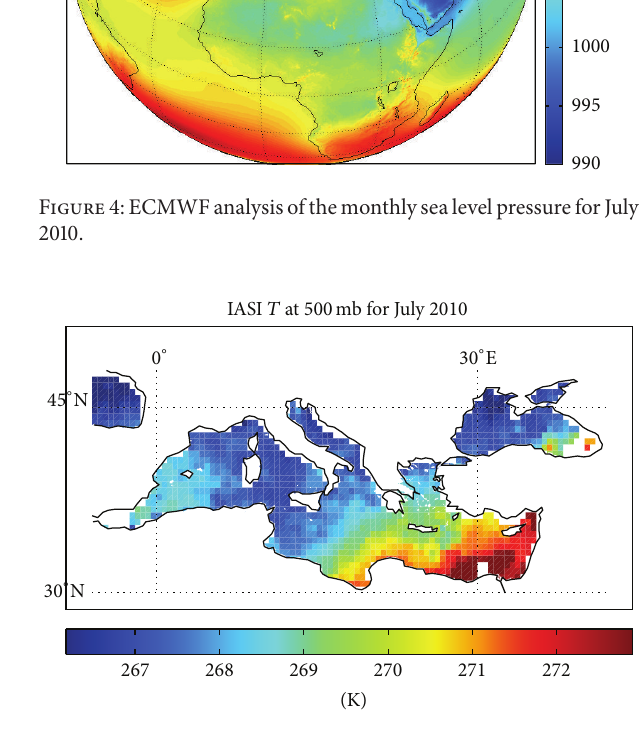
Figure 5: Retrieved atmospheric temperature at 500 mb for the month of July 2010. Data have been smoothed and rendered on a grid of 0.5 ∘ × 0.5 ∘ (lat. ×